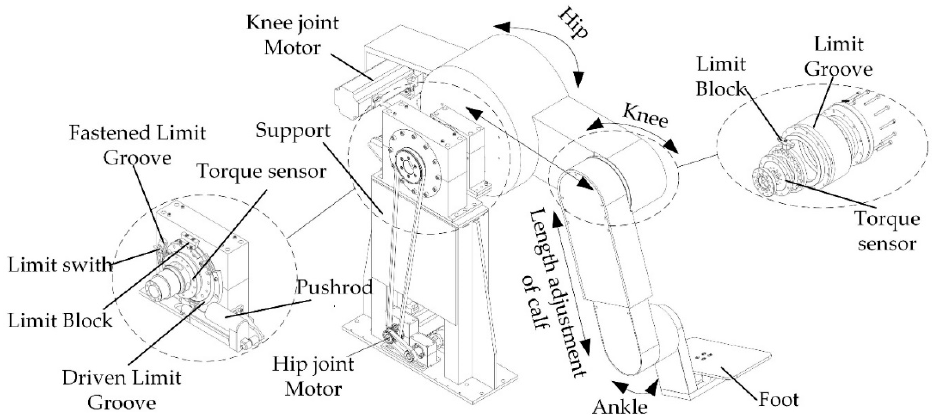
Figure 2. The detailed design of LLR-II leg mechanism.